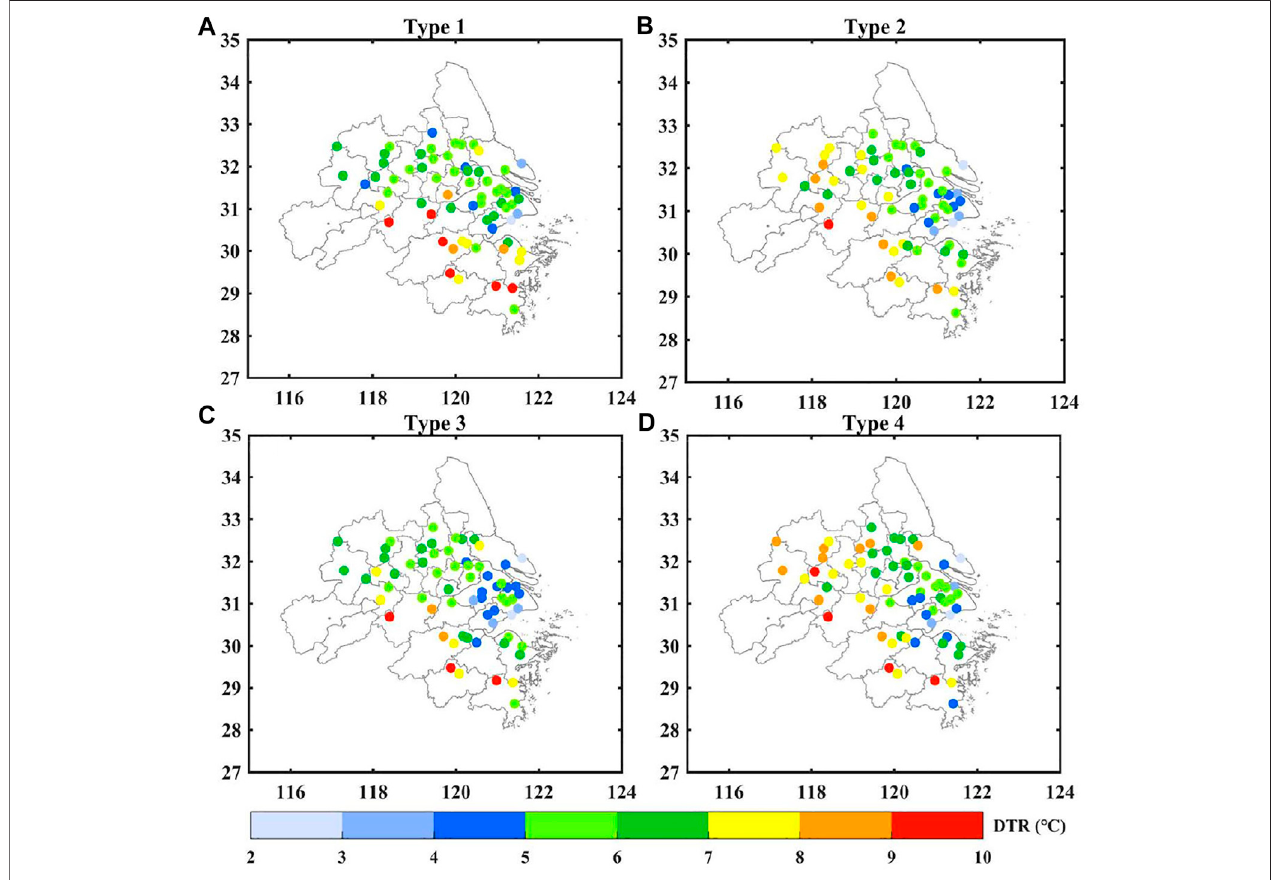
FIGURE 9 | Spatial distribution of mean DTR in the YRDUA region: (A) Type 1; (B) Type 2; (C) Type 3; and (D) Type 4.